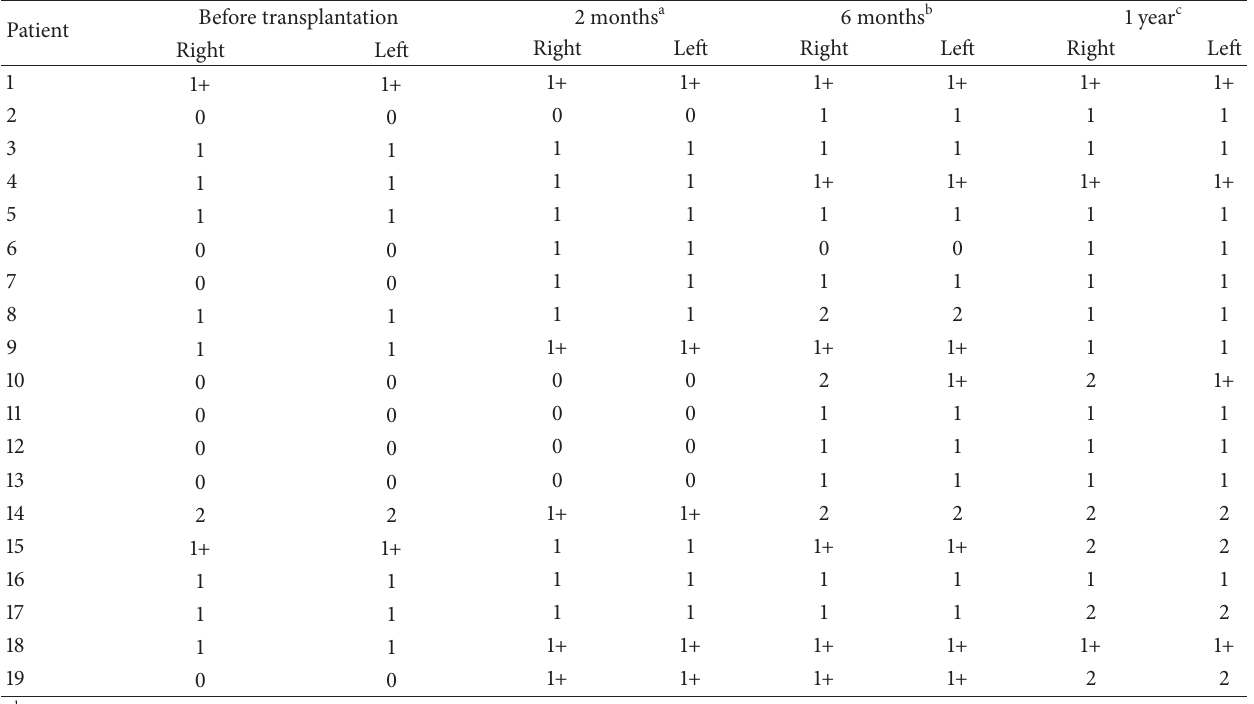
Table 2: Changes of spasticity in upper extremities of patients with cervical SCI using modified Ashworth scale.